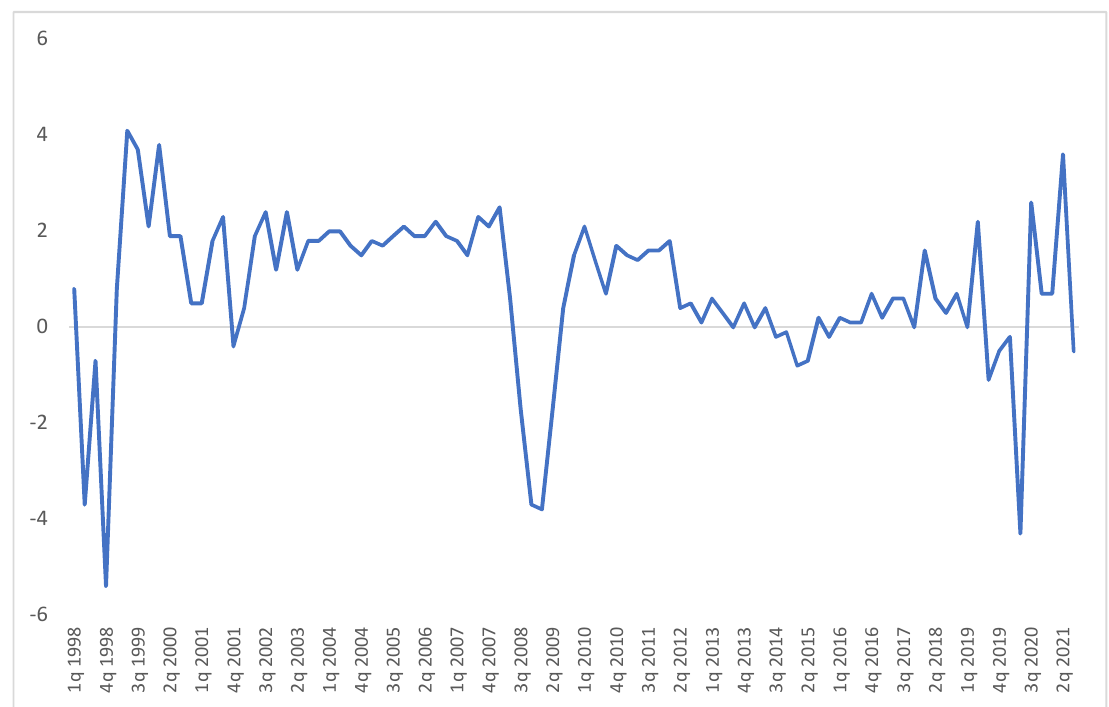
Figure 2. Dynamics of Russian ruble against the US $ and GDP (1998–2021). Source: Own visualization based on Trading Economics (2021).